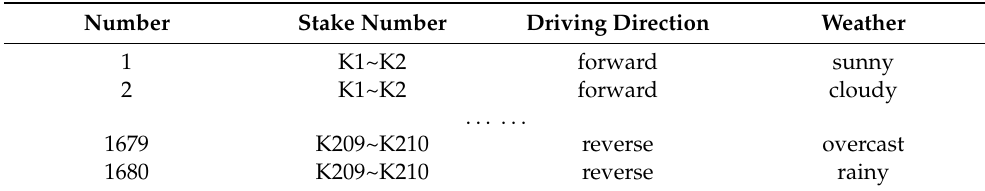
Table 1. Overview of the sampled units used in this